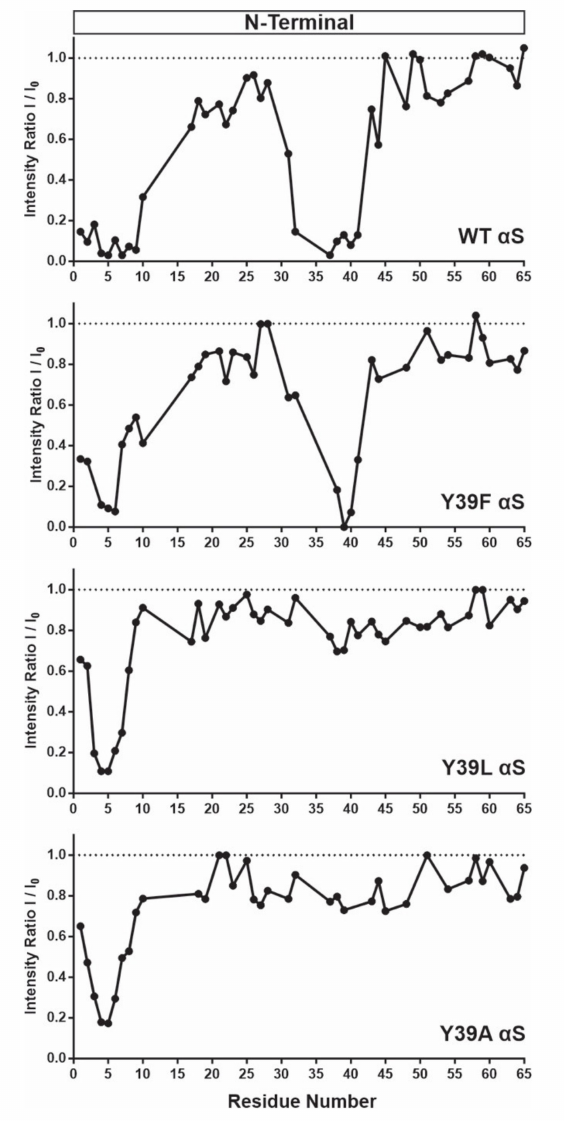
Figure 7. Structural characterization of the interaction between phthalocyanine tetrasulfonate and the Y39 α S mutants monitored by NMR spectroscopy. I / I µ M wt , Y39F, 0 profiles of backbone amide groups of 50 Y39L, and Y39A α S proteins in the presence of 50 µ M phthalocyanine tetrasulfonate (PcTS). Binding sites for the α S-PcTS complexes at the N-terminal region of the protein are shown. 1 H– 15 N HSQC spectra were recorded at 15 ◦ C using 15N isotopically enriched α S samples (50 µ M) dissolved in Buffer